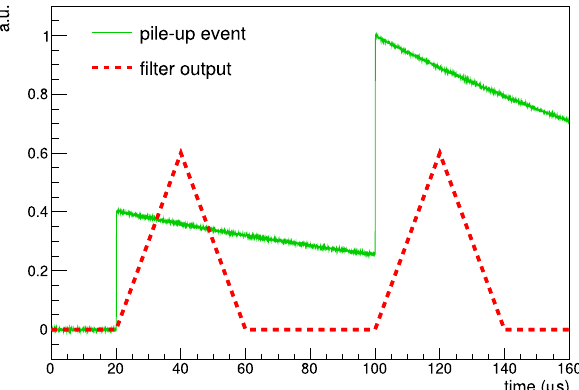
Fig. 1 This figure shows two simulated germanium detector “piled- up” pulses at the DPLMS filter input (green continuous line) and the corresponding filter output signals (red dashed line), proving that the “pile-up” condition is removed at the filter